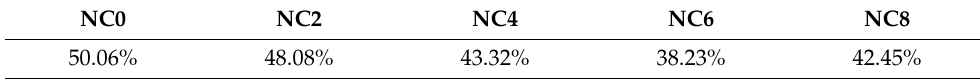
Table 2. Fitting results of crystallinity of various nanofiber membranes.